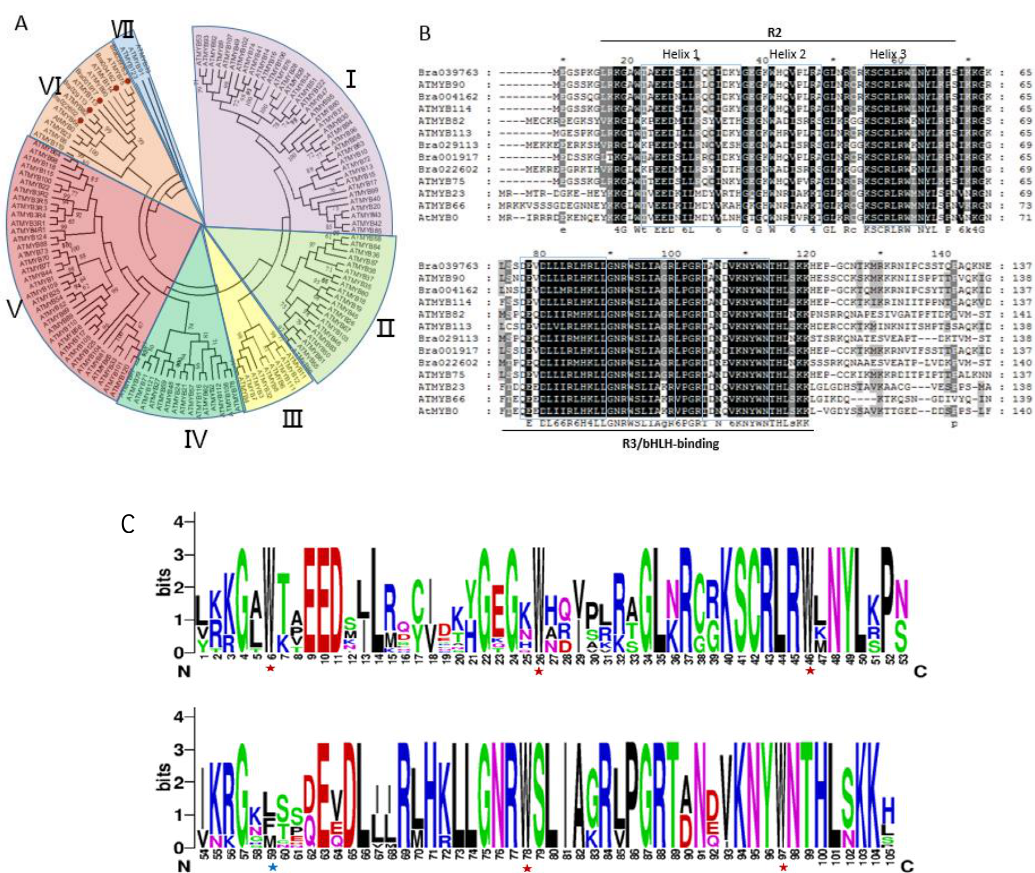
Figure 4. Phylogenetic analysis of candidate BrMYBs and multiple sequence alignment of R2R3 MYB family in Brassica rapa and AtMYBs in Arabidopsis . ( A ) The phylogenetic tree was constructed by using the Neighbor-Joining method [58] with 1000 bootstrap replicates [59]. Branches corresponding to partitions reproduced in less than 40% bootstrap replicates are collapsed. The evolutionary distances were computed using the Poisson correction method [60] and were conducted in MEGA7 [61] I to VII represents the MYB proteins divided subgroup I to subgroup VII, separately. ( B ) Protein sequences of subgroup VI were aligned by using Clustal X ver. 2 [62] with default settings, and the conserved amino acids were shaded by using GeneDoc (2.6) [63]. The R2, R3 / bHLH-binding domains are marked with black bars and three α -helices of both R2 and R3 domains are indicated by square frame [64]. ( C ) The R2R3-domain sequences from subgroup VI were aligned and the sequence conservation at a particular position expressed as a stack of letters using the WebLogo program [65]. The overall height of each stack indicates the sequence conservation at that position (measured in bits), whereas the height of symbols within the stack reflects the relative frequency of the corresponding amino acid. The conserved tryptophan residues (Trp, W) in the MYB domain are marked with red asterisks. The replaced residues in the R3 repeat are shown by blue asterisks.